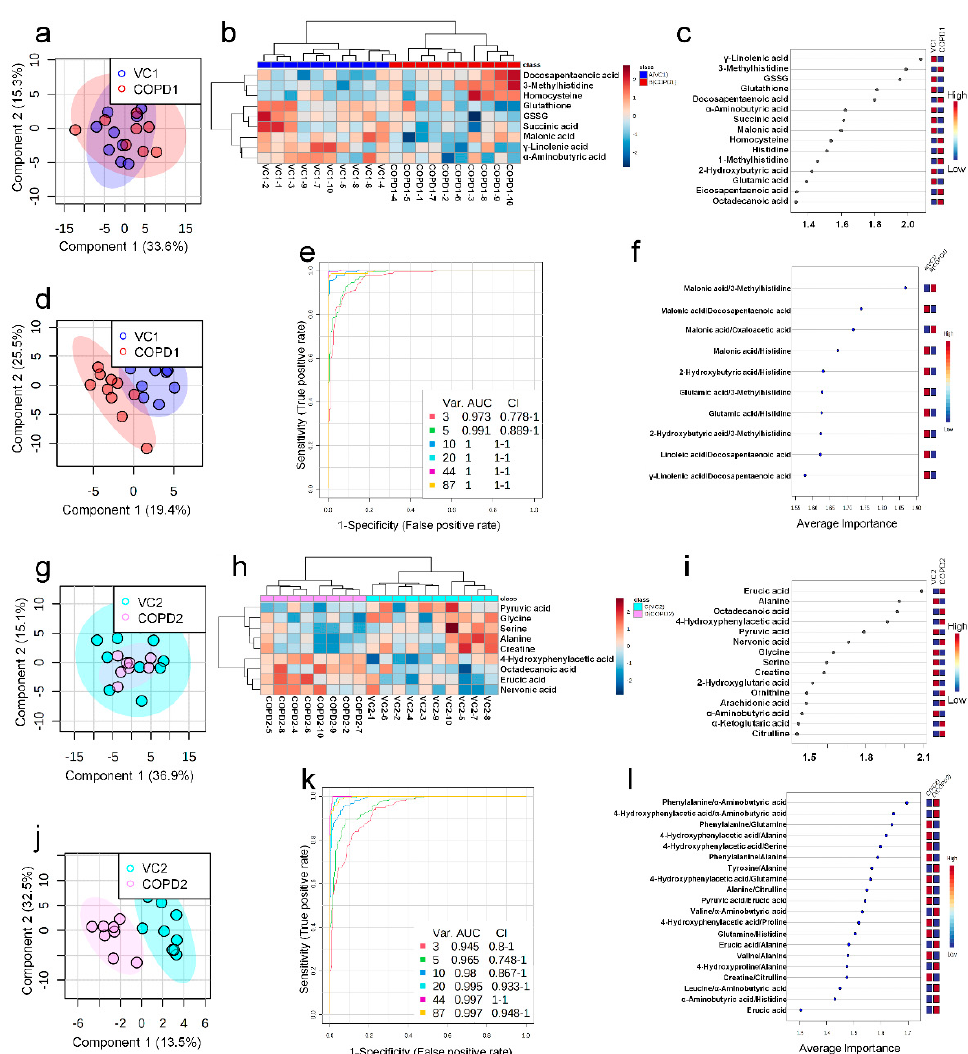
Figure 3. PCA scores plot ( a ), hierarchical clustering heatmap of 9 significant metabolites ( b ), VIP score of top-15 metabolites in PLS-DA ( c ), PLS-DA scores plot ( d ), multivariate ROC curve analysis ( e ), average importance of 10 metabolite combination in multivariate ROC curve analysis ( f ) of plasma in COPD1 and VC1 groups. PCA scores plot ( g ), hierarchical clustering heatmap of 9 significant metabolites ( h ), VIP score of top-15 metabolites in PLS-DA ( i ), PLS-DA scores plot ( j ), multivariate ROC curve analysis ( k ), average importance of 20 metabolite combinations in multivariate ROC curve analysis ( l ) of plasma in COPD2 and VC2 groups.